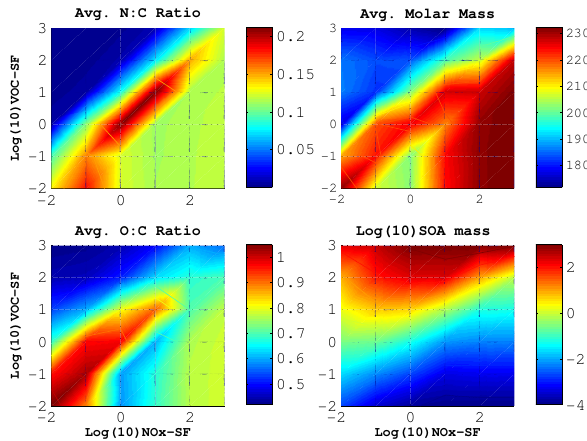
Fig. 1. Surface plots of key properties for those scenarios with AVOC-SF = BVOC-SF; the log 10 VOC-SF being plotted on the y axis and log 10 NO x -SF along the x axis in all 4 subplots; all at con- ditions T = 293 . 15K, %RH = 70 and 3.0µgm − 3 involatile core; p 0 by N-N/VP, γ i = 1. SOA mass is in µgm − 3